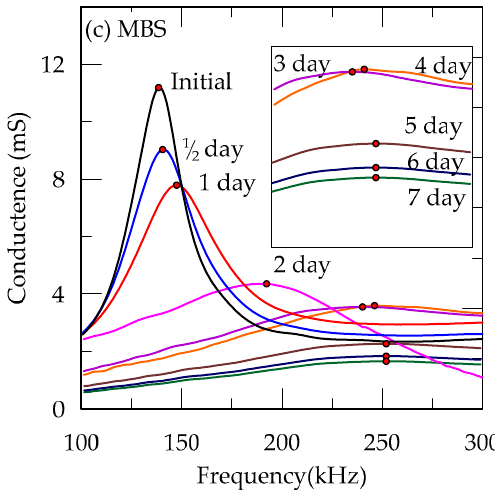
Figure 5. Conductance spectral responses from the PZT sensor placed in ( a ) standard STD, ( b ) modified (MOD), and ( c ) modified + BFS (MBS) binder-strengthened sand. Materials 2020 , 13 , x FOR PEER REVIEW